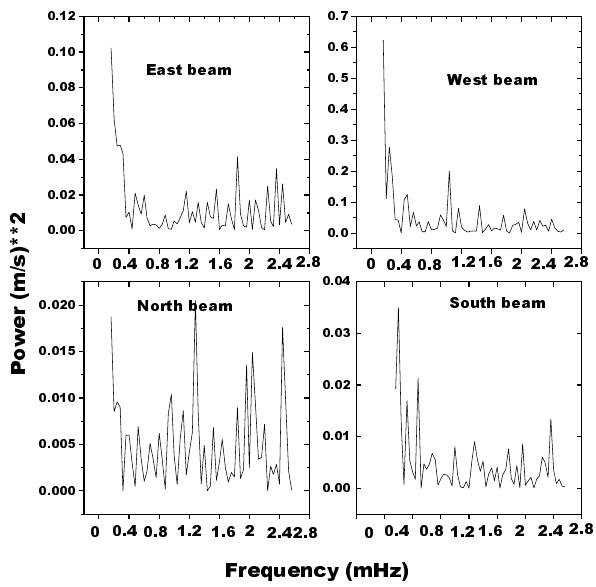
Fig. 9. The spectrum of radial velocities observed using east, west, north and south beams at 14.1km altitude on 28 August 1999.